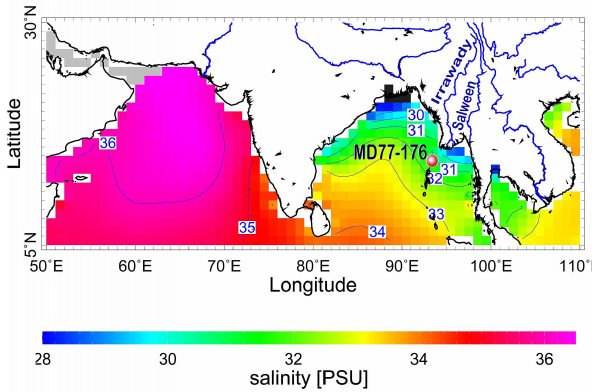
Fig. 1. Location map of the sediment core MD77-176 in the Bay of Bengal: 14 ◦ 31 0 N, 93 ◦ 08 0 E; 1375m water depth. Superimposed on the map is the present-day annual mean surface salinity of the northern Indian Ocean (data from Levitus et al., 1994).